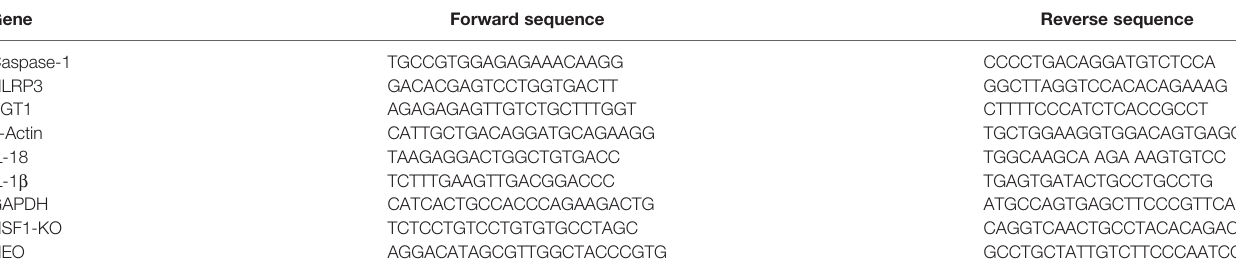
TABLE 1 | PCR primer